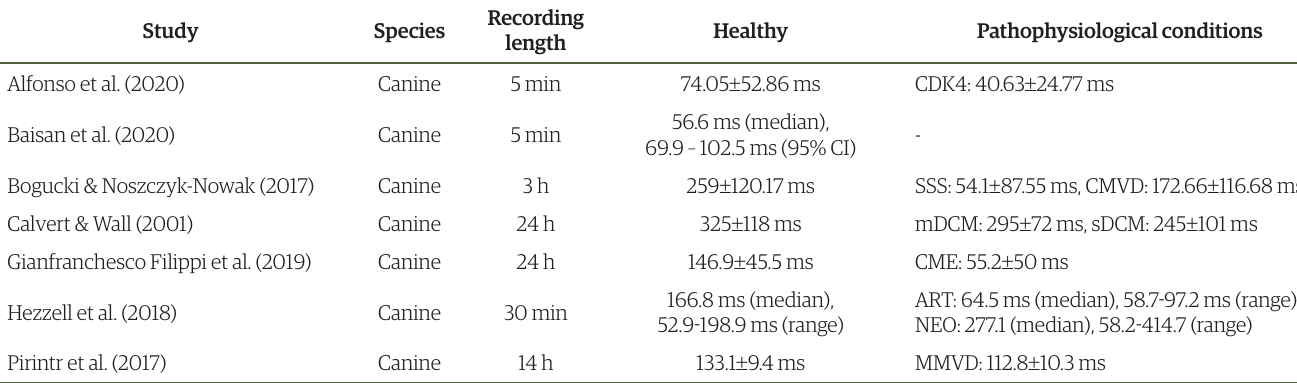
Table 4. Summary results of selected studies from the literature, depicting the recording length for data acquisition and the RMSSD values for healthy animals or those presenting pathophysiological